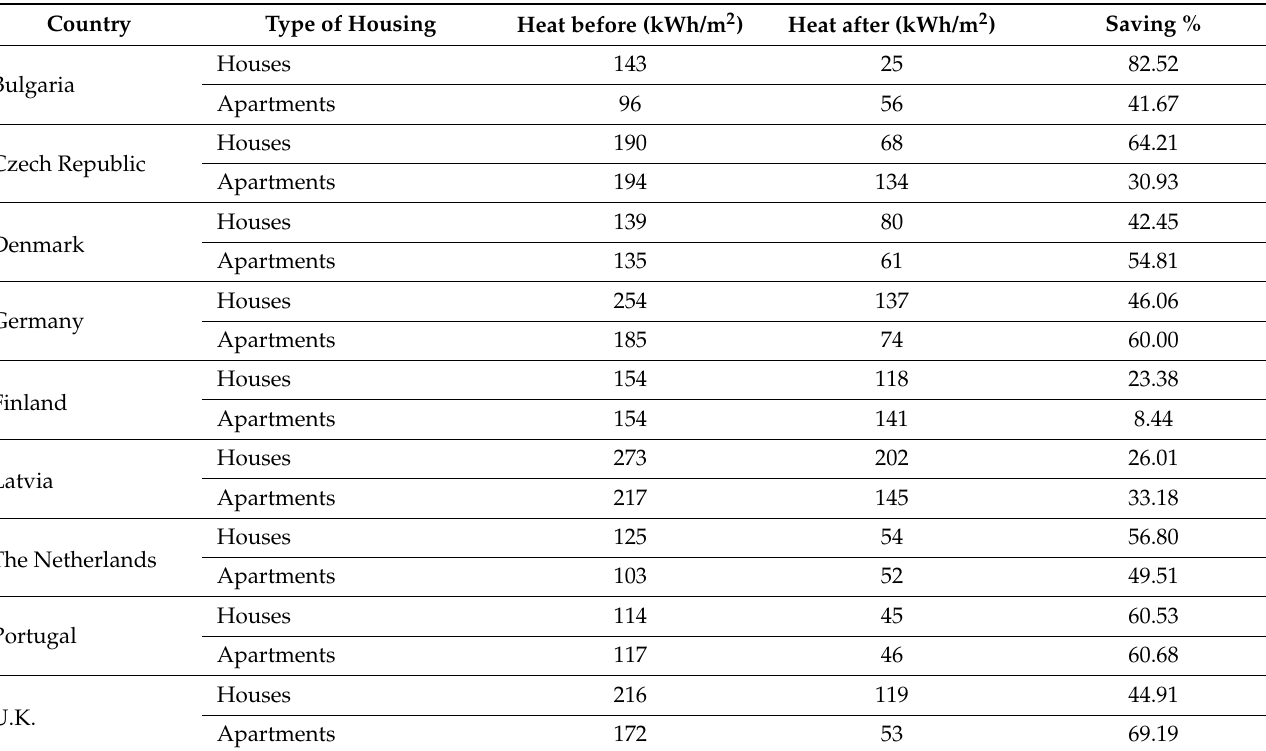
Table 6. Expected saving potential under the EPBD for existing